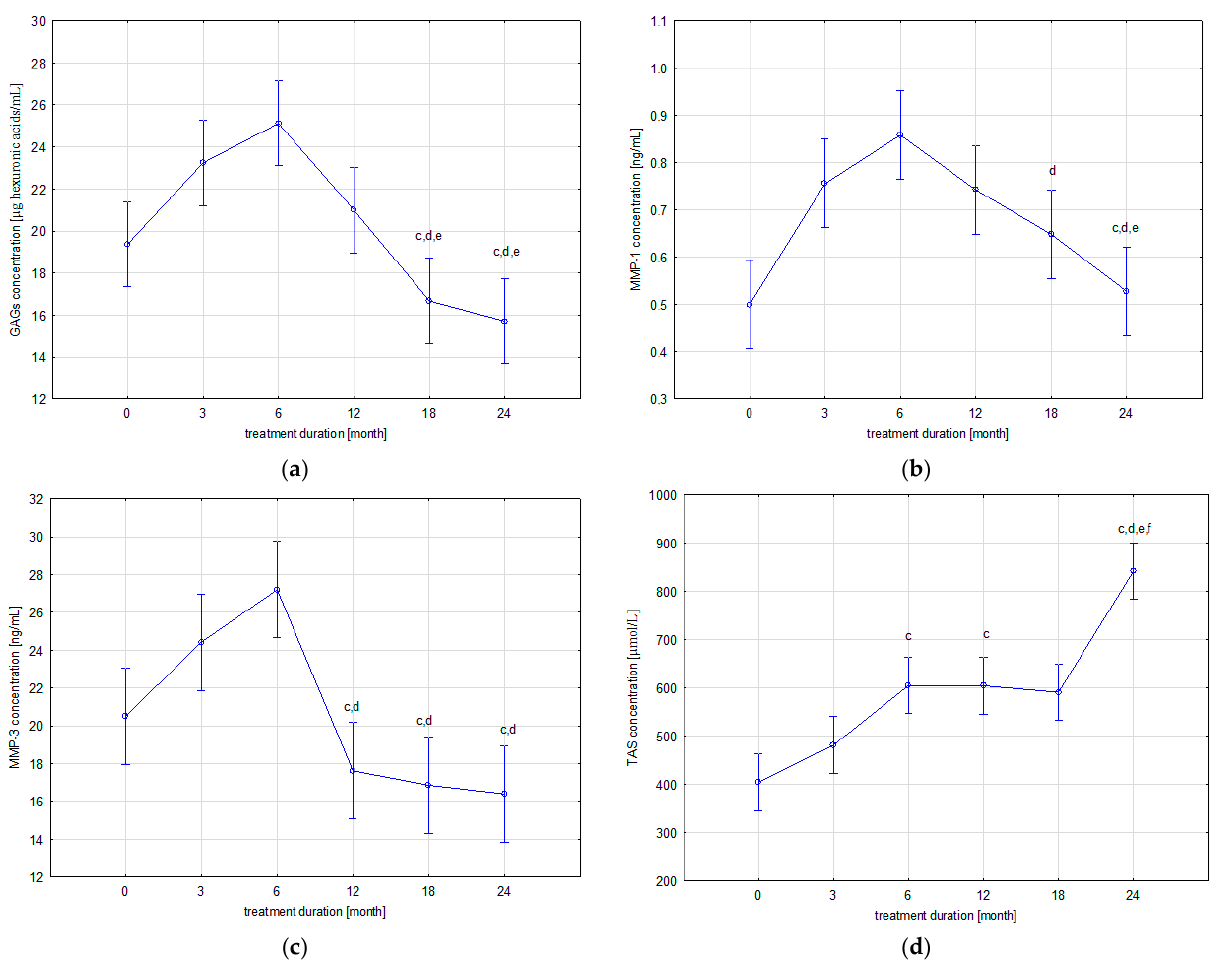
Figure 1. Dynamics of changes in plasma levels of GAGs ( a ), MMP-1 ( b ), MMP-3 ( c ), and TAS ( d ) in patients with JIA before and during etanercept therapy; c p < 0.05 compared to T3 group; d p < 0.05 compared to T6 group; e p < 0.05 compared to T12 group; f p < 0.05 compared to T18 group.